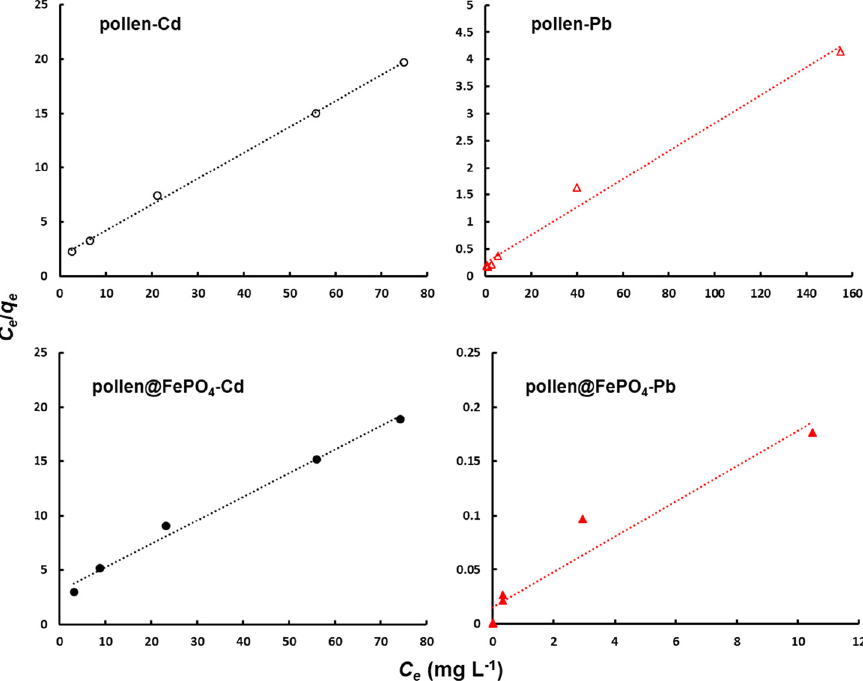
Figure 10: Langmuir isotherm plots of Cd 2 + /Pb 2 + on pollen@FePO 4 /pollen microspheres. Sample: 50 mL, initial pH 5.92; adsorbent dose 0.3278 g pollen@FePO 4 /pollen; contact time 60 min.